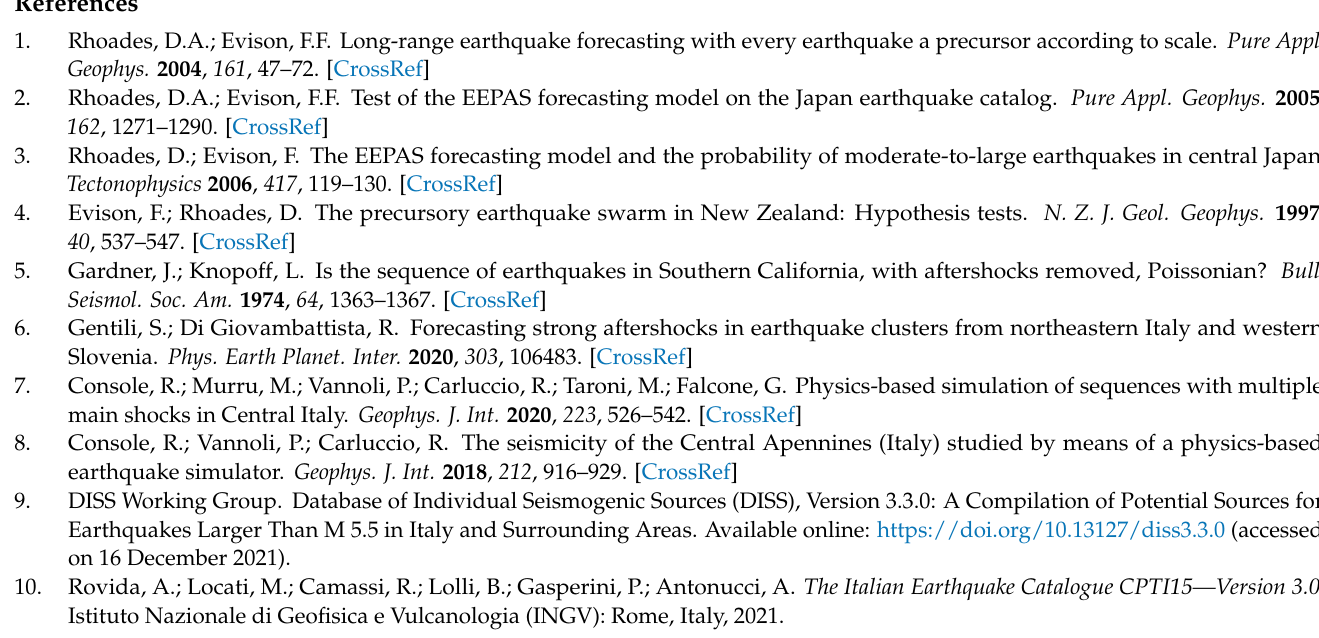
Figure S1: Cumulative and density magnitude–frequency distributions of M w ≥ 4.2 earthquake sim- ulated catalogs, for the nine combinations of free parameters of Table 3 considered in this study. The straight dotted lines show the best-fit Gutenberg–Richter distributions. Figure S2: Stacked number of M w ≥ 4.2 earthquakes that preceded and followed an M w ≥ 5.2 earthquake within an epicentral distance of 20 km in the 100,000 years simulated catalog, for the nine combinations of free parameters of Table 3 considered in this study. Figure S3: (a) Stacked number of M w ≥ 4.2 earthquakes that preceded and followed up to 0.1 years (36.5 days) an M w ≥ 5.2 earthquake within an epicentral distance of 50 km in the 100,000 years simulated catalog. (b) b-value in the time bins of 0.365 days before and after an earthquake of M w ≥ 5.2 containing at least 10 events, for the nine combinations of free parameters of Table 3 considered in this study. Figure S4: Sketch of a quadrilateral fault